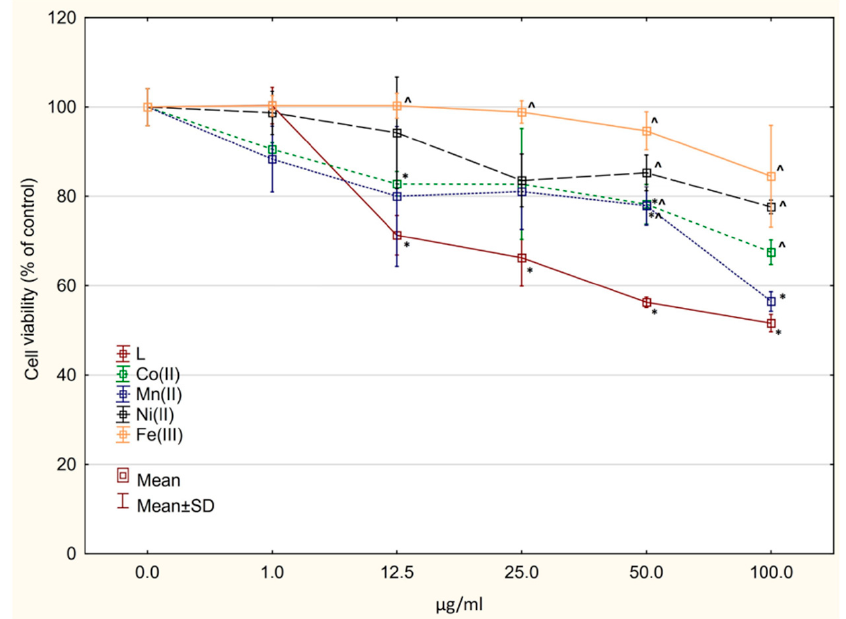
Figure 8. Cytotoxic activity of the investigated complexes and the ligand alone against LN229 cancer cells. * p < 0.05 vs. control culture, ^ p < 0.05 vs. ligand (in corresponding concentrations).